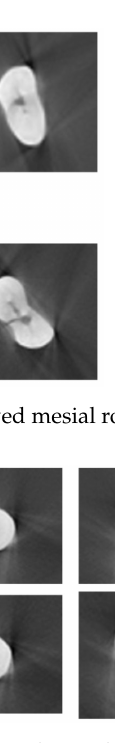
Figure 4. Three sections of severely curved mesial roots before ( up ) and after ( down )